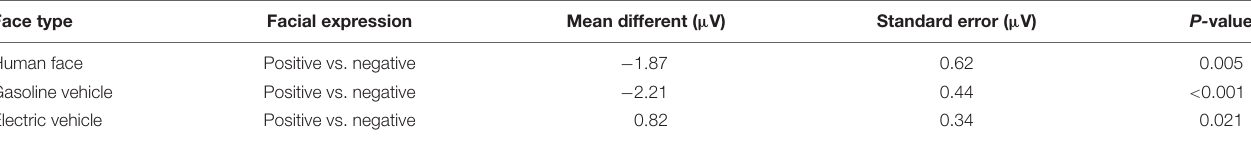
FIGURE 6 | (A) Grand-averaged ERPs for positive expressions on human, gasoline vehicle, and electric vehicle faces recorded in the centro-parietal region and topographic maps corresponding to the experimental conditions. (B) Grand-averaged ERPs for negative expressions on human, gasoline vehicle, and electric vehicle faces recorded in the electrodes of the centro-parietal region and topographic maps corresponding to the experimental conditions. The red line represents human faces; the purple line represents gasoline vehicle faces; the blue line represents electric vehicle faces. TABLE 2 | Multiple comparisons of EPN amplitude in the face type